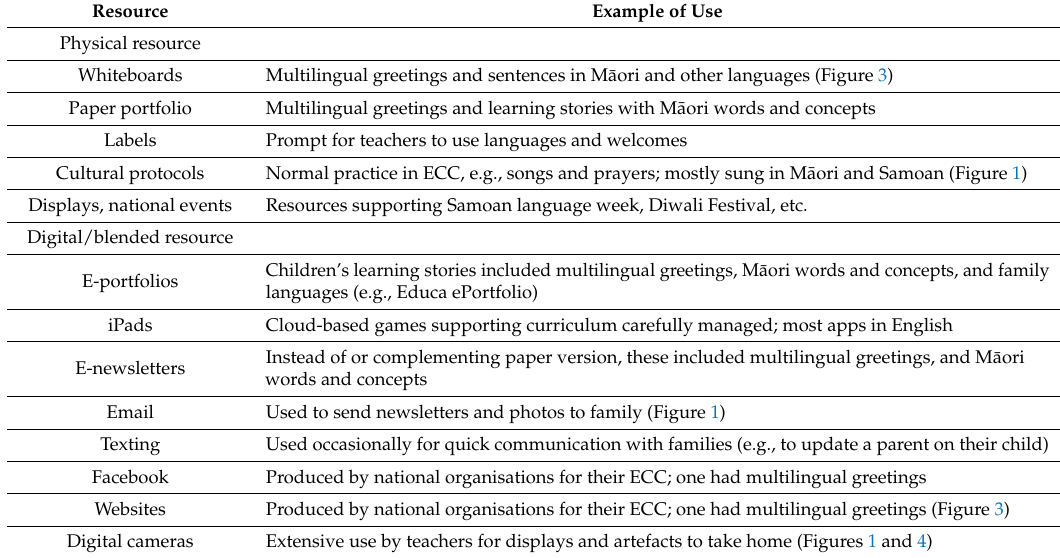
Table 3. Representative sample of resources commonly observed in the six ECCs, classified by purpose(s) and an illustrative use. Figures refer to the examples of ECC